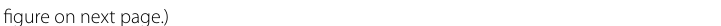
LMG25706(See figure on next Fig. 1 Disease symptom of E . mori on plants and its epidemics in kiwifruit orchards of Cangxi. a High disease incidence caused by E . mori led to eradication of whole kiwifruit orchards. b The canker-like disease symptoms on the trunk with white exudation. c Reddish-brown discoloration under the bark of the trunk. d Disease symptom of brown spots on kiwifruit leaf. Disease symptom of kiwifruit ( Actinidia deliciosa cv. Hayward) leaf after inoculation of E . mori CX01 ( e ) or E . mori LMG25706 ( f ). g The symptoms of E . mori CX01 and LMG25706 inoculated mulberry ( Morus alba L.)leaf. h and I Twigs ( Actinidia chinensis cv. Hongyang) showing brownish necrosis after puncturing inoculation with E . mori CX01 or